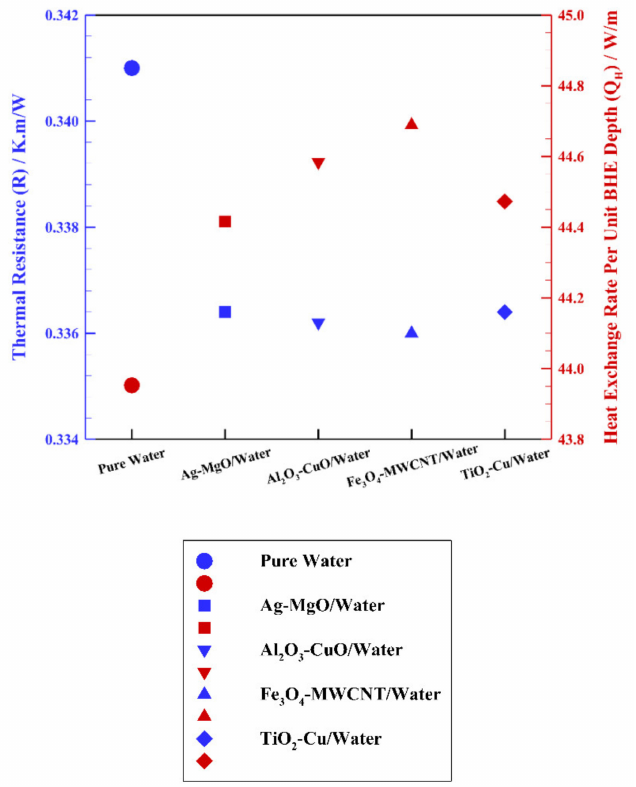
Figure 6. The total thermal resistance of the borehole and the surrounding soil and the heat exchange rate per unit BHE depth for various hybrid nanofluids at φ = 0.15 and Re =